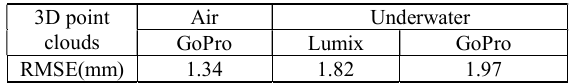
Table 5. Accuracy comparison of 3D point clouds generated using Lumix and GoPro camera systems in air and